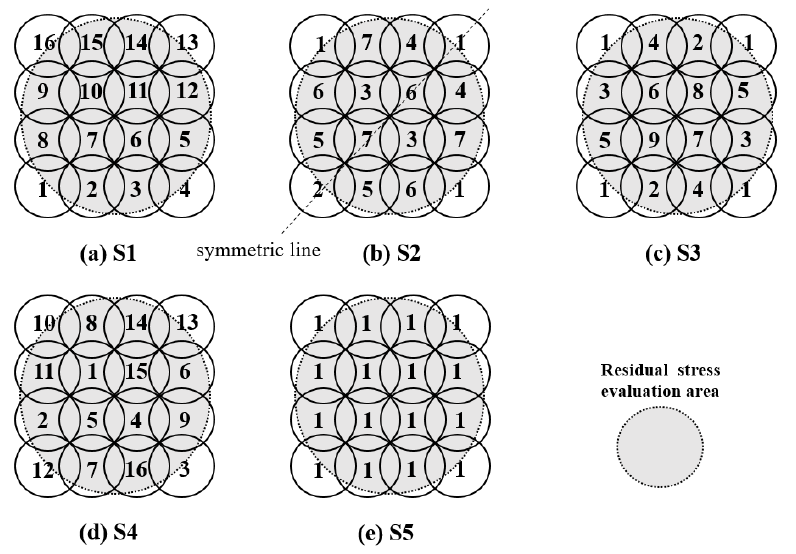
Figure 10. Schematic diagram of dimple pattern and impact sequence in 16-shots model. ( a ) S1; ( b ) S2; ( c ) S3; ( d ) S4; ( e ) S5. ( b ) S2; ( c ) S3; ( d ) S4; ( e )